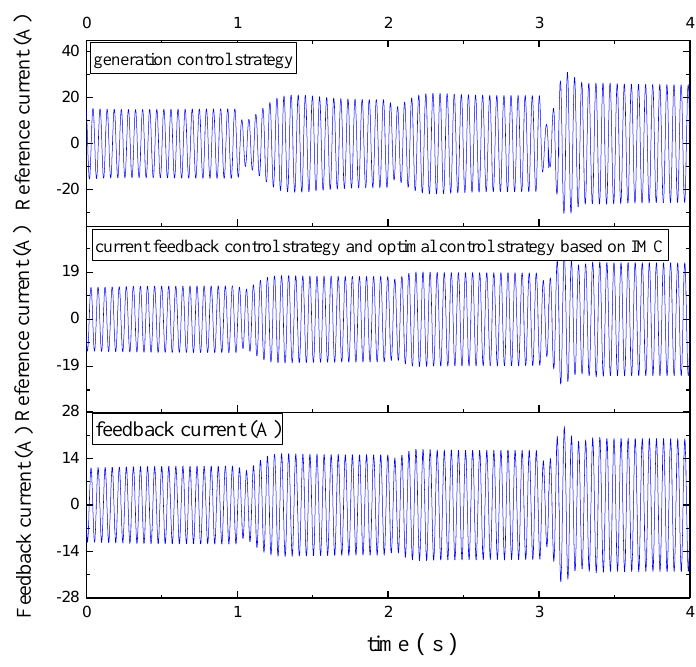
Figure 10. Comparison of q -axis reference current and feedback current of different control strategies.